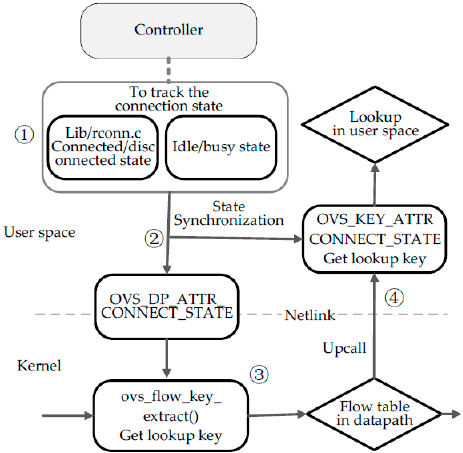
Figure 4. Connection-state processing module. Step 1 is to track the connection state. Step 2 is to transmit the state detected to the kernel and user space. Step 3 is to support a stateful match in the kernel. Step 4 is to support a stateful match in user